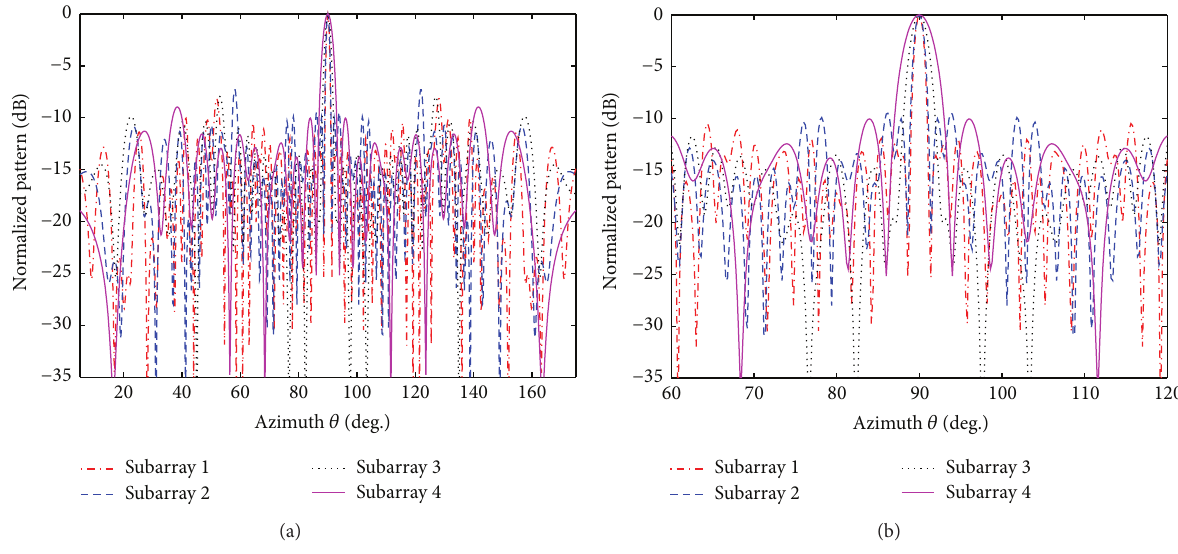
Figure 3: (a) Normalized power pattern for the subarrays. (b) Magnification of the pattern for the interleaved subarrays.